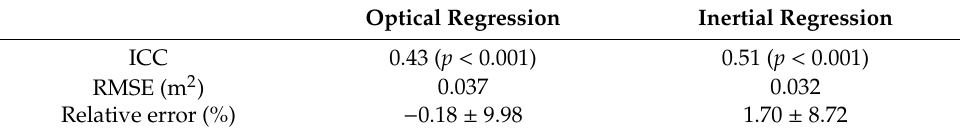
Table 5. The accuracy of both regression models in terms of ICC, RMSE, and relative